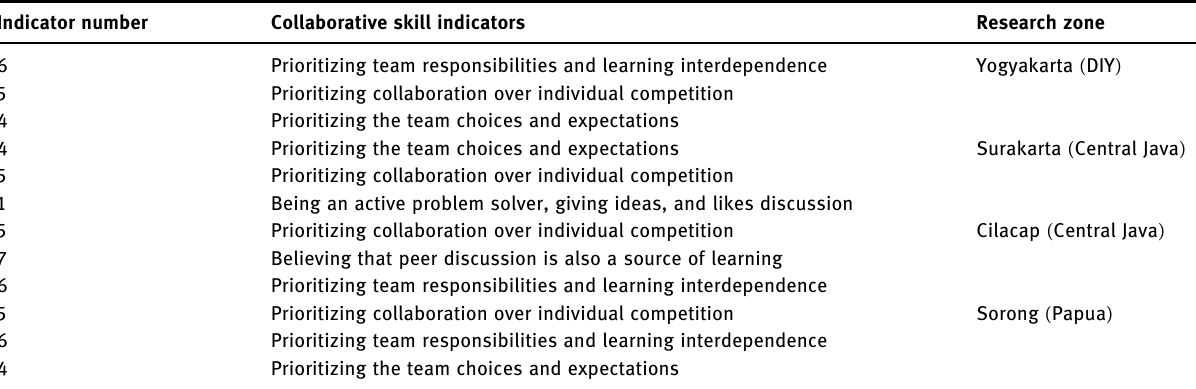
Table 10: Lowest collaborative skill indicators for each zone from descriptive analysis result Indicator number Collaborative skill indicators Research